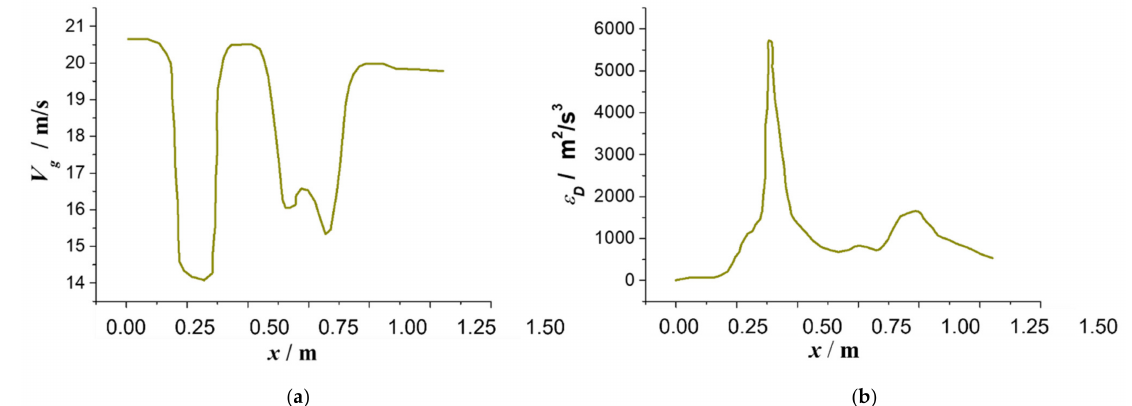
Figure 9. Cross-section-averaged distributions of ( a ) gas velocity and ( b ) TKE dissipation rate along the exhaust